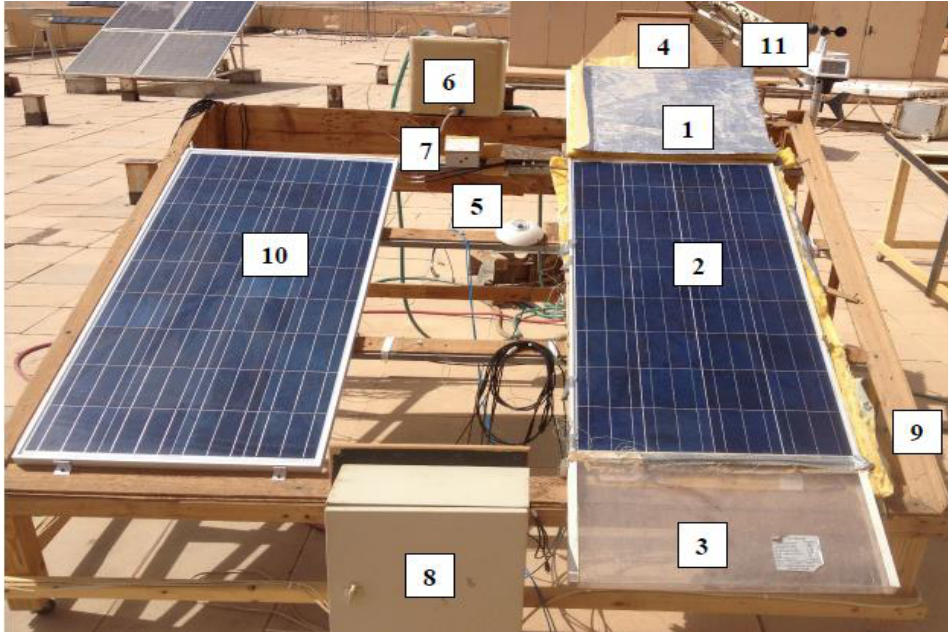
Figure 3. Experiment set up: 1: entrance section, 2: PV panel with cooling, 3: exit section, 4: fan (20W) assembly, 5: pyranometer, 6: water tank, 7: water flow meter, 8: electrical connection box, 9: wooden pool with 24° inclination facing south, 10: reference panel and 11: weather station.